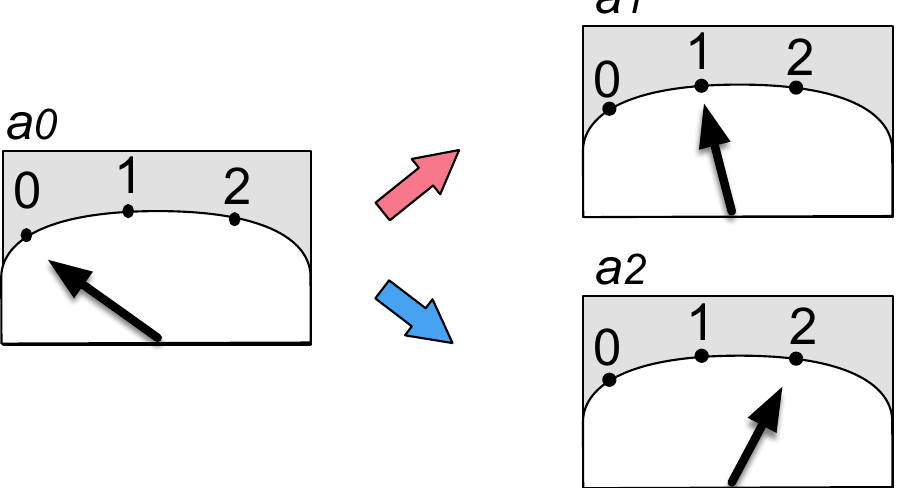
Figure 3. Measurement (or observation) as a material process proceeds from left to right, forward in time as the arrows indicate. Events occur in the order of a 0, a 1, ..., a 0, a 2 in the meters. However, the inverse causality process proceeds from right to left, backward in time by logic. New symbols, b 1 and b 2 in Sequence 1b are generated behind a 0 from a 1 and a 2, respectively, with the inverse-causality (IC) model. The measurement based on IC requires at least two entities: a meter and its reader (not shown), both of which compose the subject, without assuming any object to be measured; the meter is within the subject, not outside.